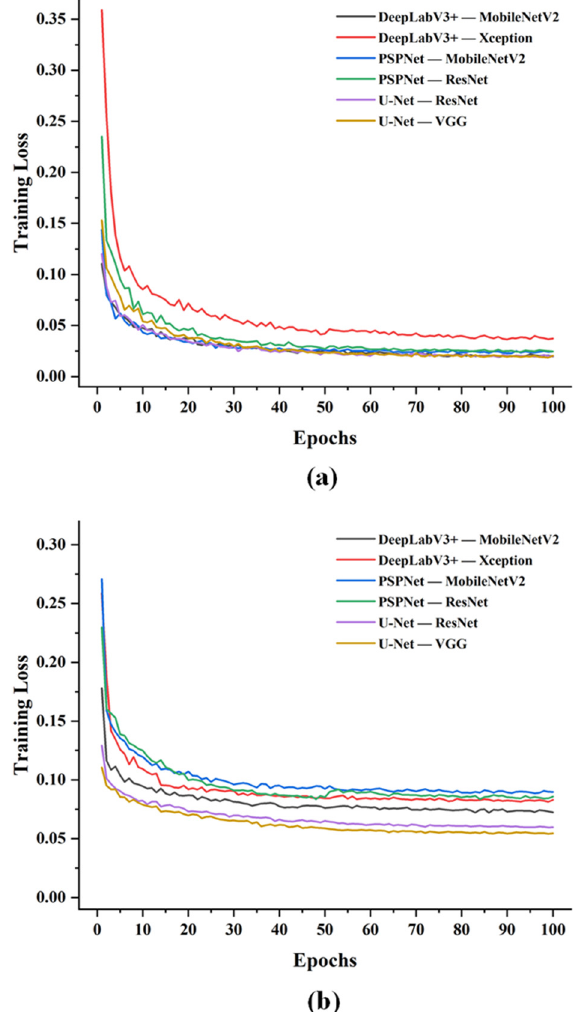
Figure 4. Training curves of loss against number of epochs on identifications of ( a ) apple leaves and ( b ) disease areas.